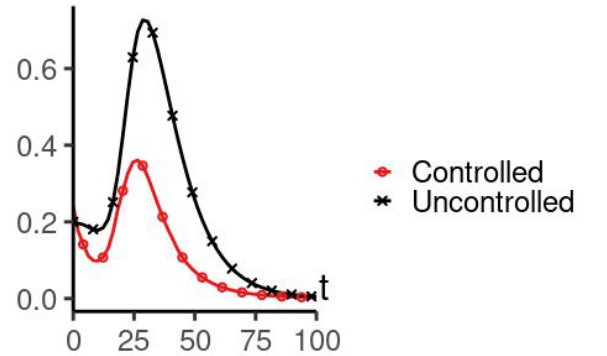
Figure 20. Experiment 3. Aggregation costs in uncontrolled and controlled cases with responsible in- dividuals.